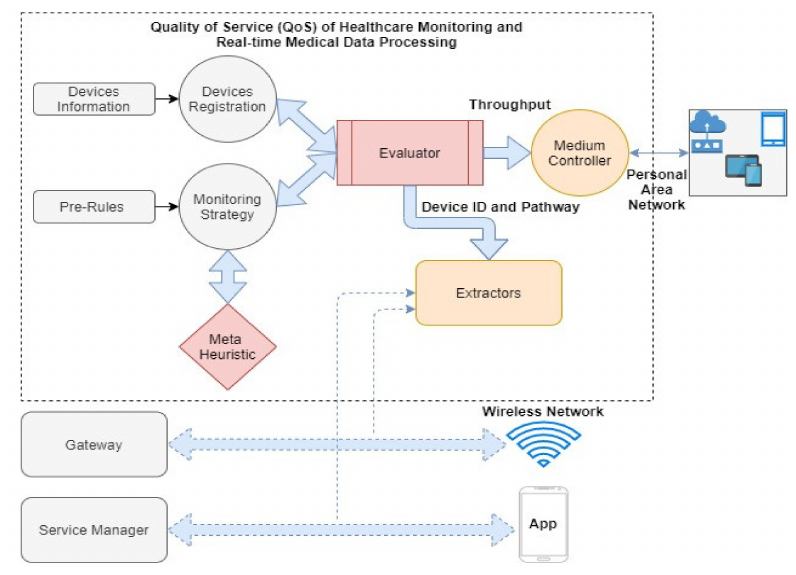
Figure 1. The current healthcare quality-of-service (QoS) monitoring